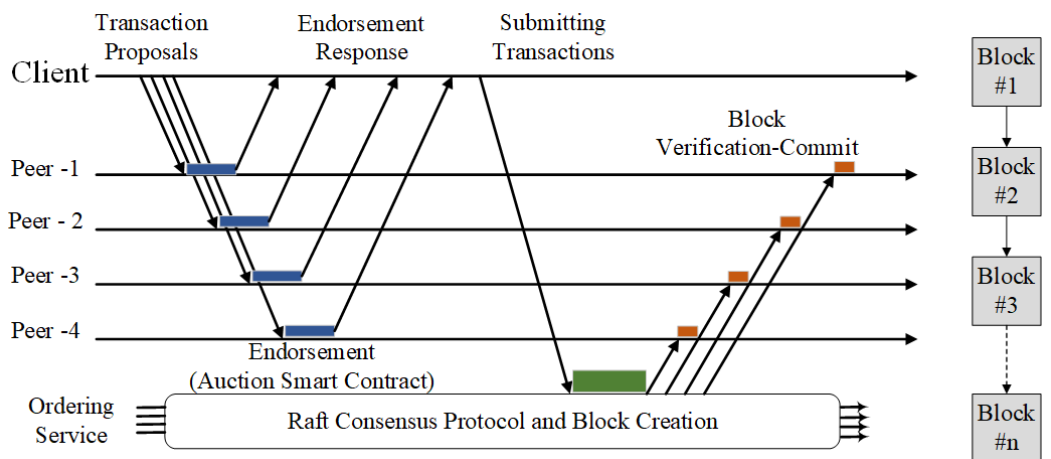
Figure 1. Overview of the RAFT consensus protocol and block